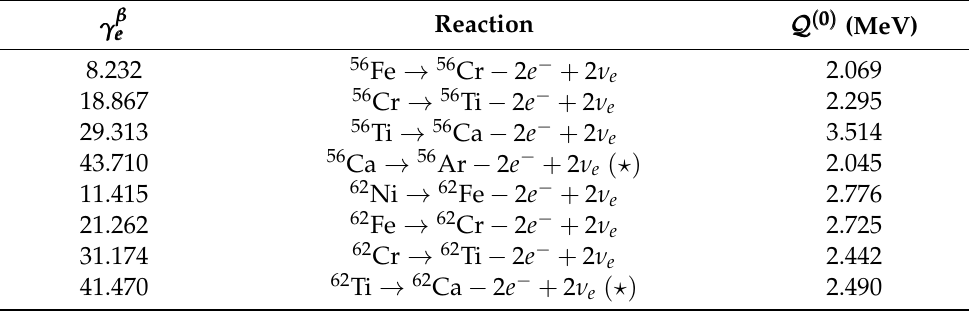
Table 4. Values of the nuclear parameters γ β e and Q ( 0 ) (considering ground-state to ground-state transitions) from which the threshold density and pressure for the onset of electron captures, as well as the heat released can be calculated. The symbol ( (cid:63) ) is used to distinguish reactions for which theoretical atomic masses were